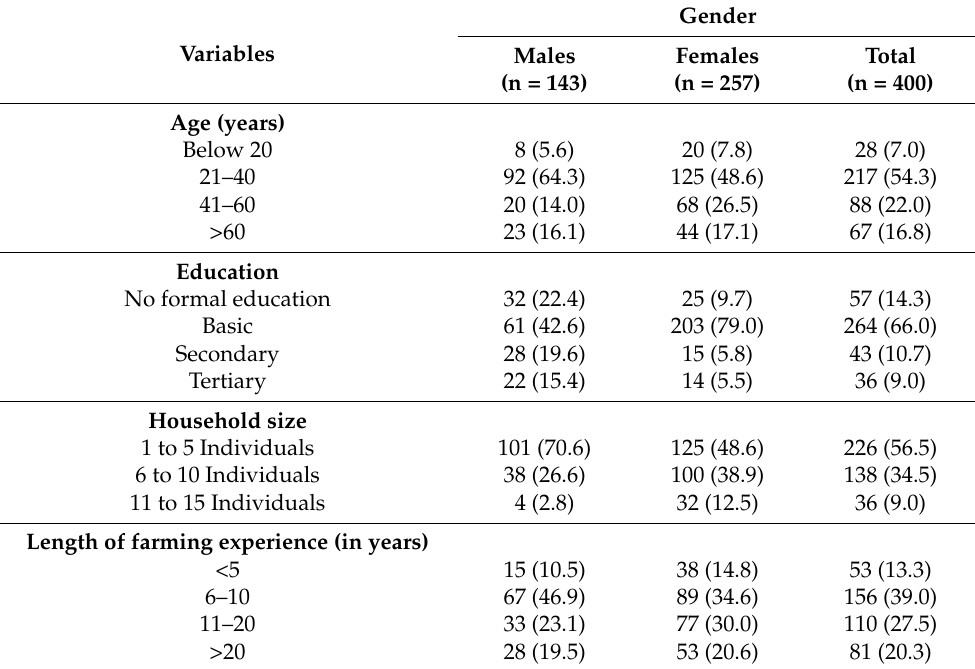
Table A1. Socioeconomic characteristics of the study